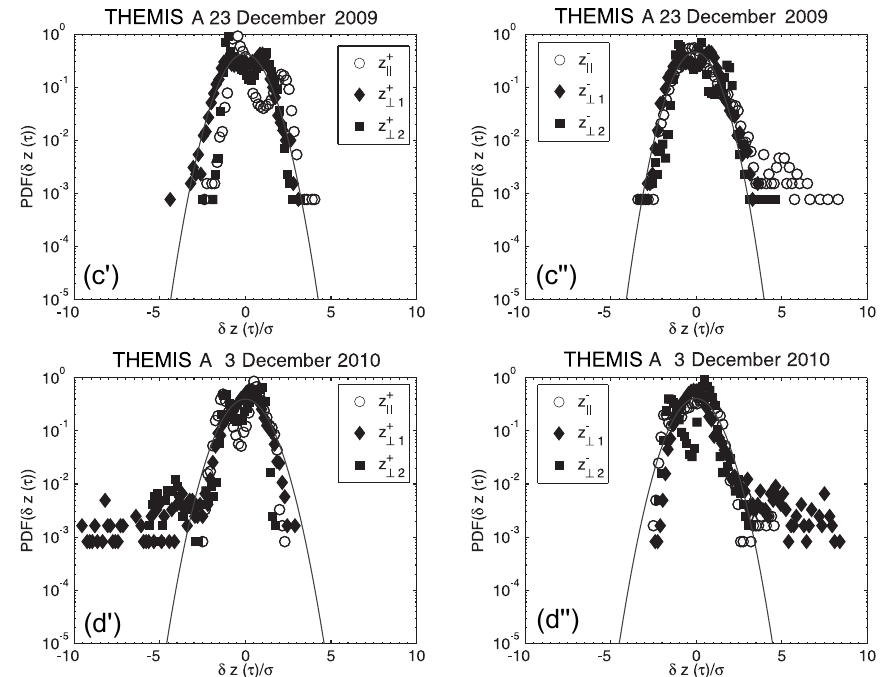
Figure 13. The probability density functions (PDFs) of the increments of the parallel (white circles) and perpendicular (black diamonds and squares) components of the Elsässer variables, δ z + (c’, d’) and δ z − (c”, d”), for a given timescale τ = 9s, near the magnetopause (cases (c) and (d) in Table